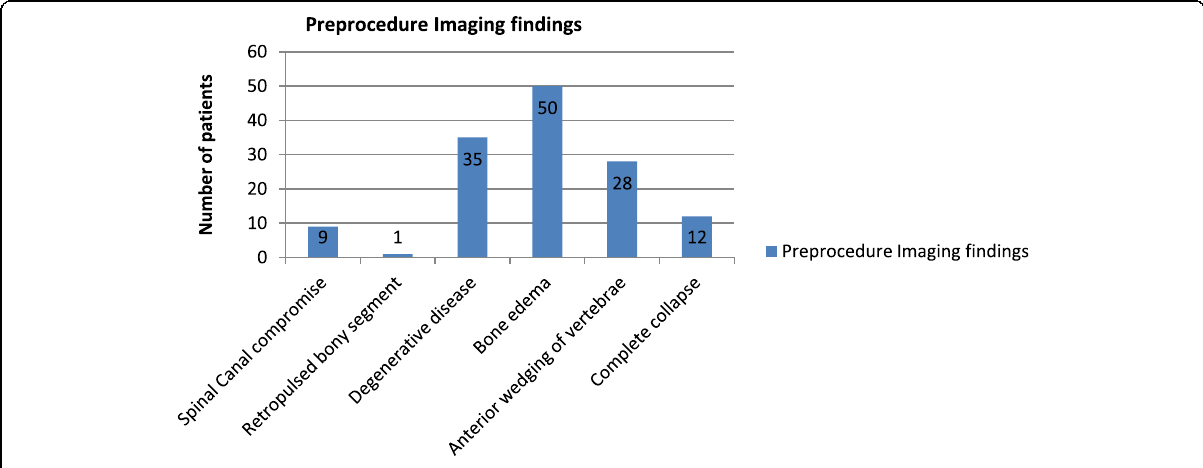
Fig. 8 Pre-procedure imaging findings